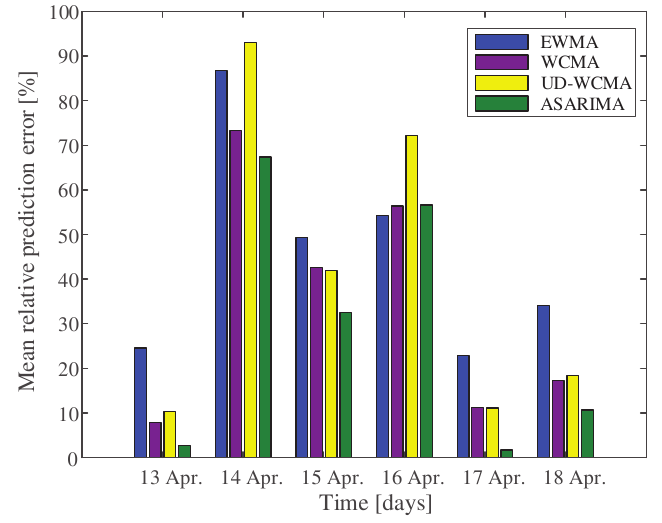
Figure 5. The relative errors of various algorithms Figures 6–8 are solar harvested power predicted results and relative prediction errors (RPE) for the different weather conditions of April 14, April 15, and April 17, respectively. The relative error of the proposed ASARIMA can also be improved despite the unstable weather conditions. For example, on April 15, the relative error of the EWMA algorithm is 49.39%, those of the WCMA and UD-WCMA algorithms are close to 42%, and that of the ASARIMA model is only 32.45%. The relative prediction efficiency of the ASARIMA algorithm is also improved by 22.7%. We present the forecast trend chart of the ASARIMA algorithm in the following days and the relative error of each prediction time for a specific analysis, as illustrated in Figure 6.